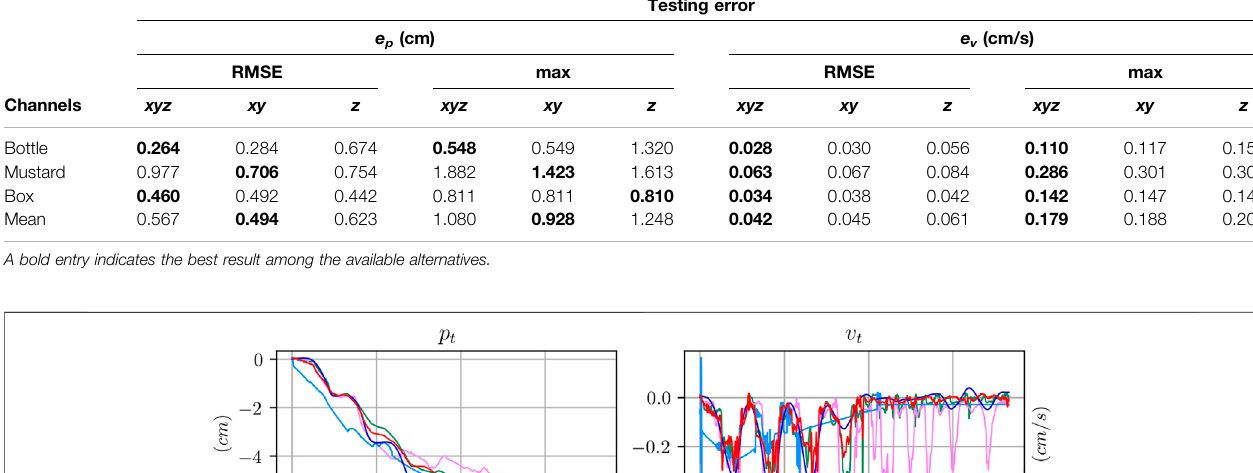
TABLE 2 | Position and velocity RMS and maximum testing errors using several con fi gurations of the tactile channels ( xyz , xy and z ).